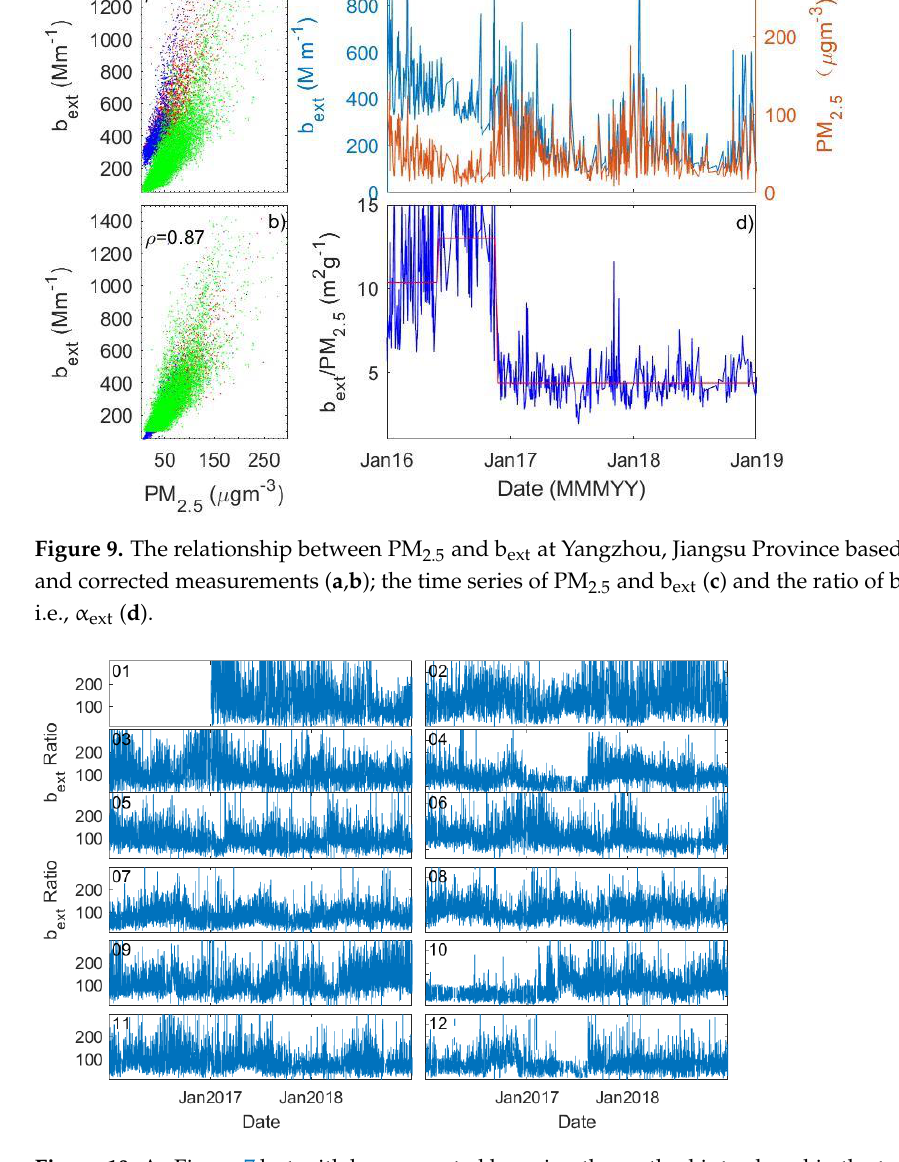
Figure 10. As Figure 7 but with b ext corrected by using the method introduced in the